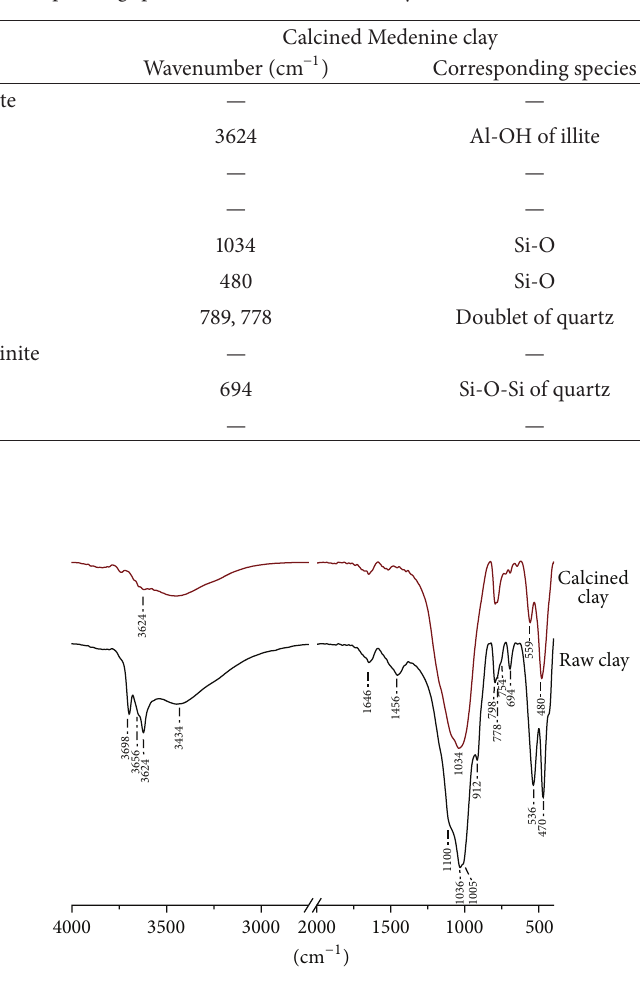
Table 3: The principal IR bands and their corresponding species of raw and calcined clay.